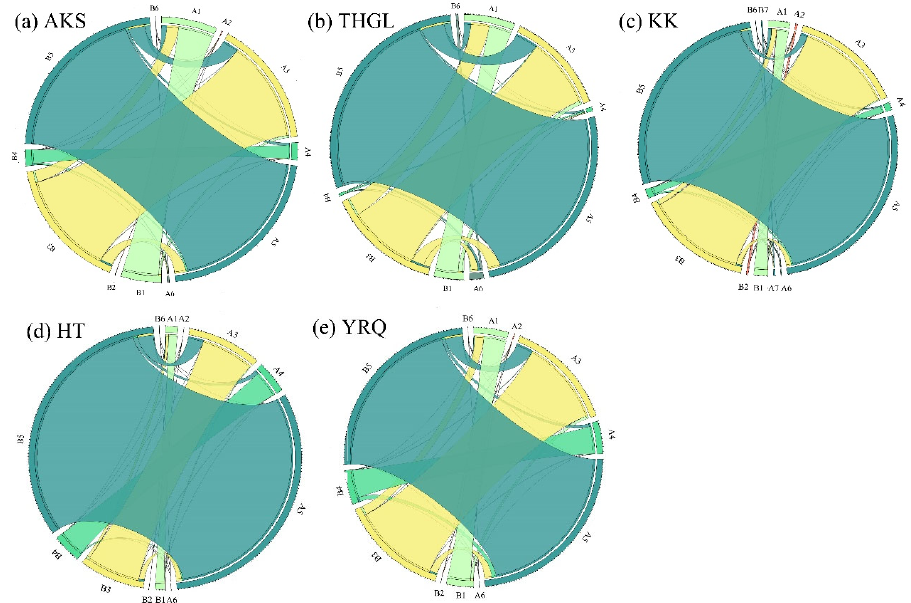
Figure 5. Current situation of land use transfer in the five sub ‐ basins of the TRB (A1–A6: land use type area in 2020; B1–B7: LUCC types area in 2000; A1/B1: cropland(CR); A2/B2: Forest(FO); A3/B3: Grassland(GR); A4/B4: water(WA); A5/B5: Barren(BA), A6/B6: built ‐ up land(BL); A7/B7: wetland(WE); Figure a – e : land use transfer for each sub ‐ basin in the study area).